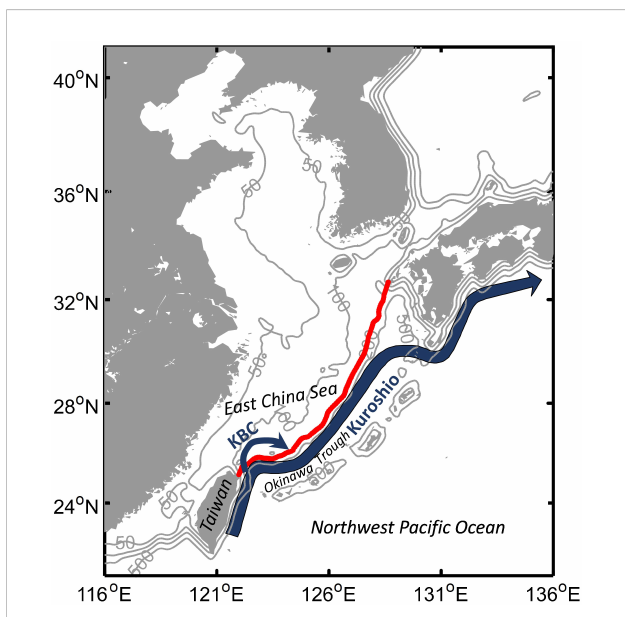
FIGURE 1 The domain of the numerical model. The gray lines are the 50 m, 100 m, 200 m, and 500 m isobaths. The 200 m isobaths along the ECS continental shelf are highlighted in red lines. The blue arrows indicate the Kuroshio Current and Kuroshio branch current